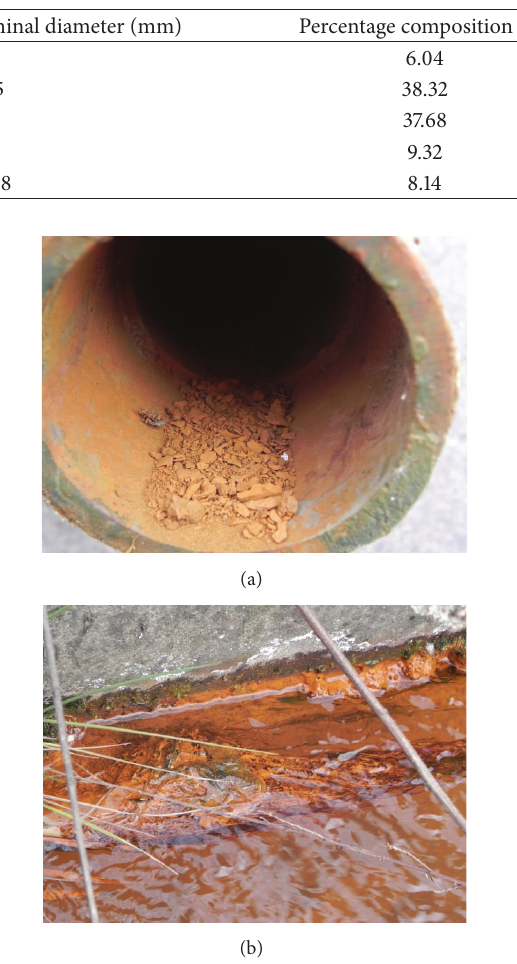
Figure 3: The chemical clogging of the Lixi tailings dam ((a) drain- pipe, (b) surface drain).